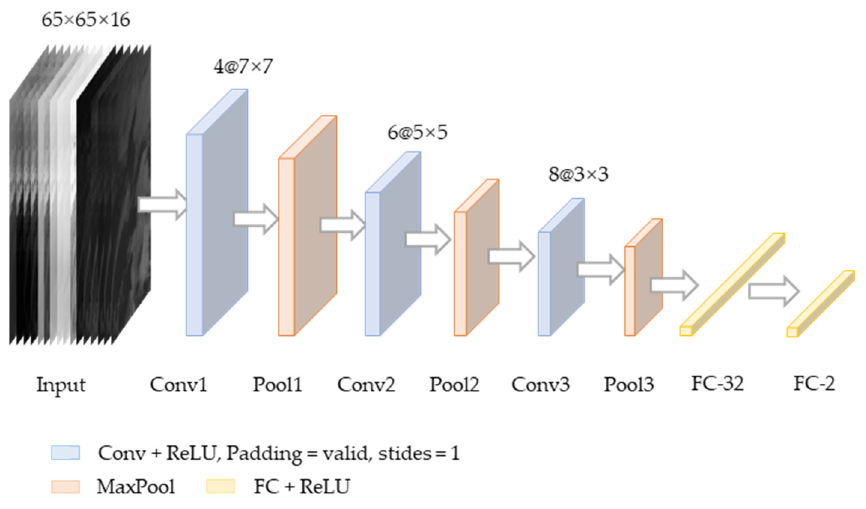
Figure 5. The architecture of the CNN proposed in this paper. The architecture consisted of three convolutions with a stride of 1, followed by a ReLU nonlinearity. Each convolution was separated by a 2 × 2 max pooling layer. Two regular densely connected layers were pushed into the stack of the structure to reduce the dimensions to two (sea fog and clouds). ReLU activations were also applied to these two fully connected layers.